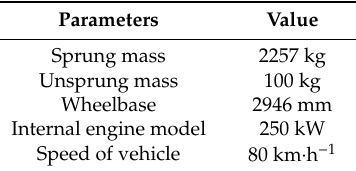
Figure 7. Road roughness.